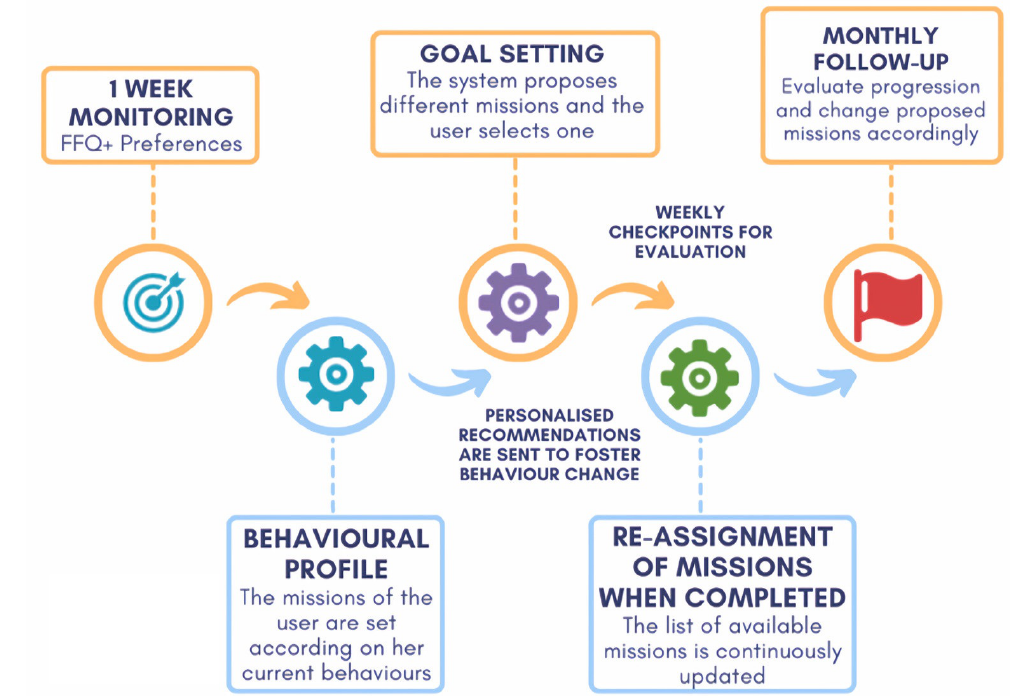
Figure 1. Behaviour Change